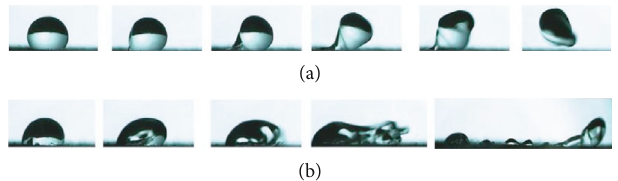
Figure 16: The movement of droplets on the surface of dry or wet GDL at air velocity of 5